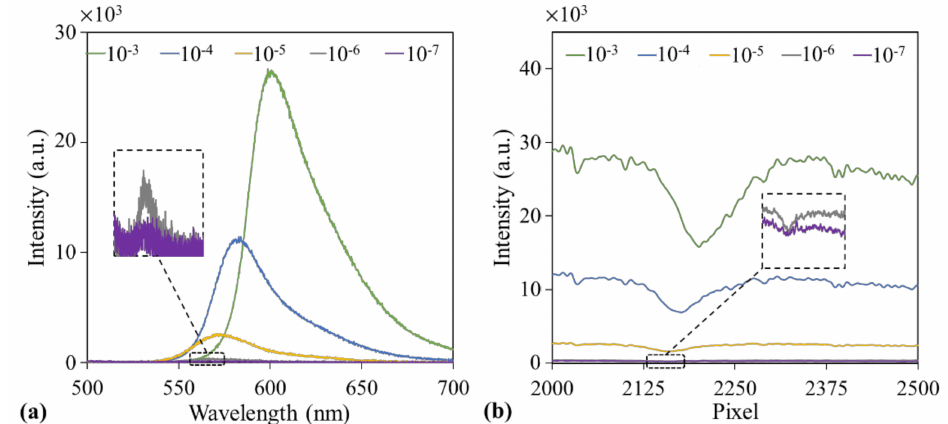
Figure 3. Fluorescence emission from different concentrations of TAMRA (5-carboxytetramethyl- rhodamine) measured using ( a ) a spectrometer and ( b ) the proposed GGP-GMR/CCD